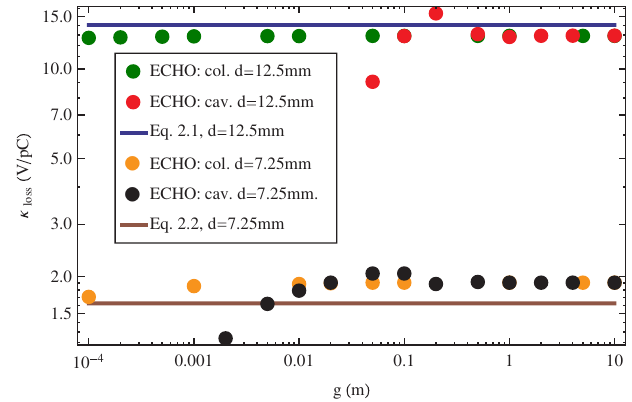
FIG. 8. (Color) For a step collimator and a pillbox cavity, the dependence of loss factor on g for (cid:1) ¼ 0 : 5 mm , b ¼ 6 : 25 mm is shown. Red and black dots represent ECHO data already shown in Fig. 6 for a pillbox cavity with d ¼ 12 : 5 mm and d ¼ 7 : 25 mm , respectively. Green and orange dots are the ECHO data corre- sponding to the collimator structure with parameters d ¼ 12 : 5 mm and d ¼ 7 : 25 mm , respectively. Equation (2.1) (blue line) and Eq. (2.2) (wine line) are also presented.